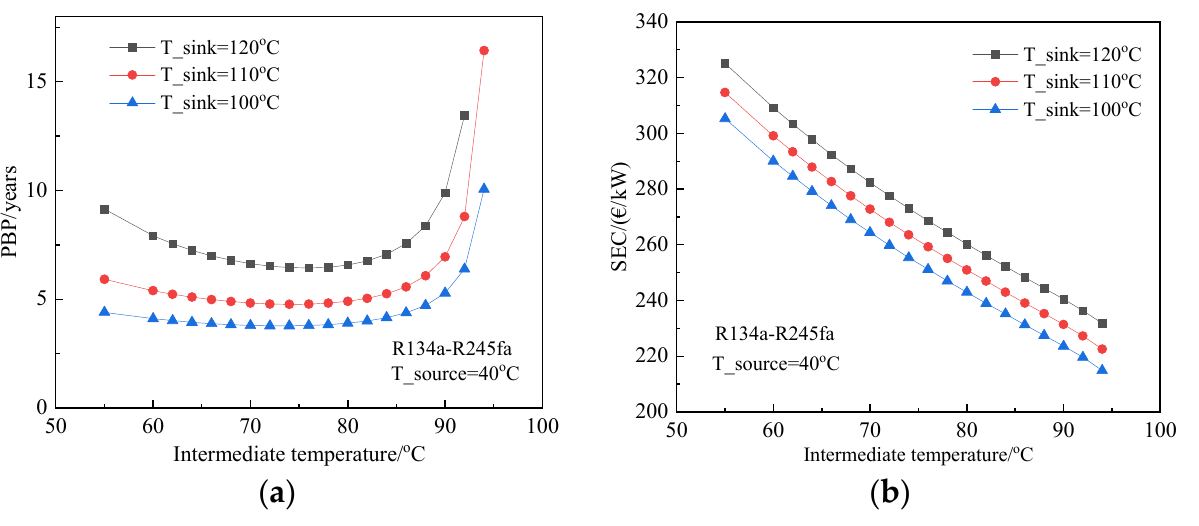
Figure 4. Effects of the intermediate temperature on the economic performance. ( a ) PBP at various intermediate temperatures. ( b ) SEC at various intermediate temperatures.